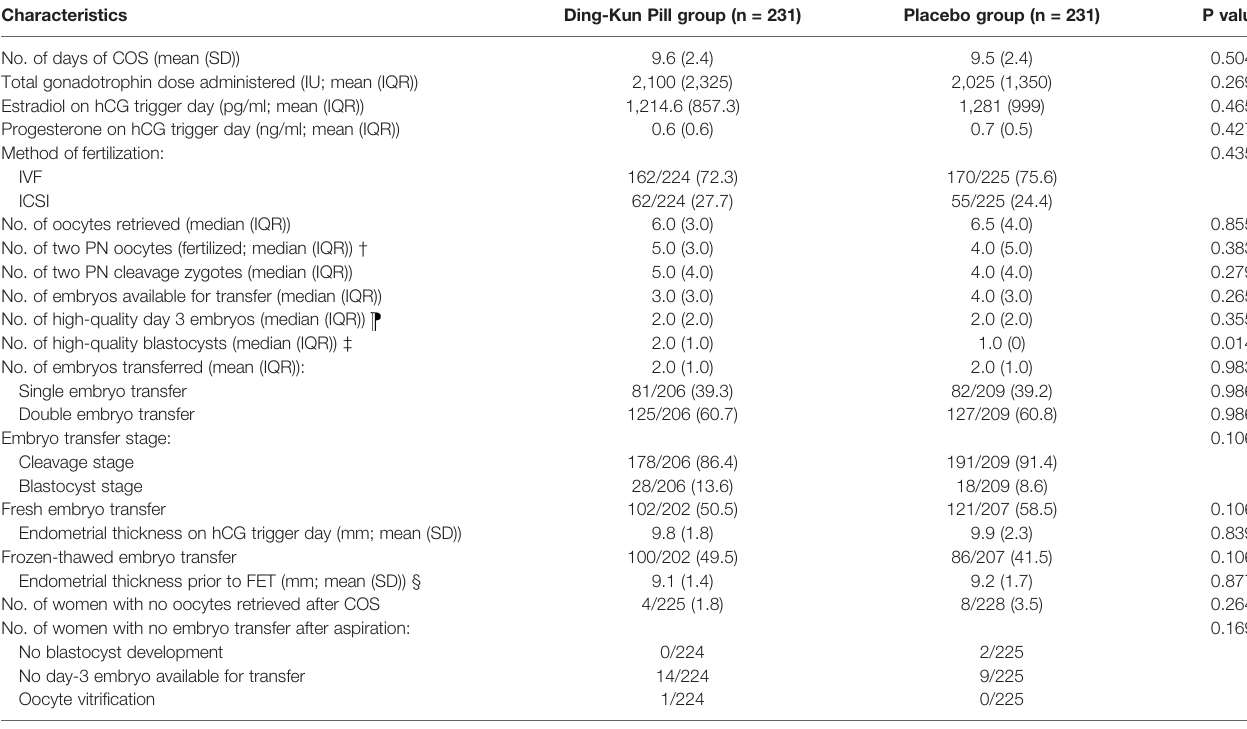
TABLE 2 | Controlled ovarian stimulation and in vitro fertilization-embryo transfer characteristics in study population.